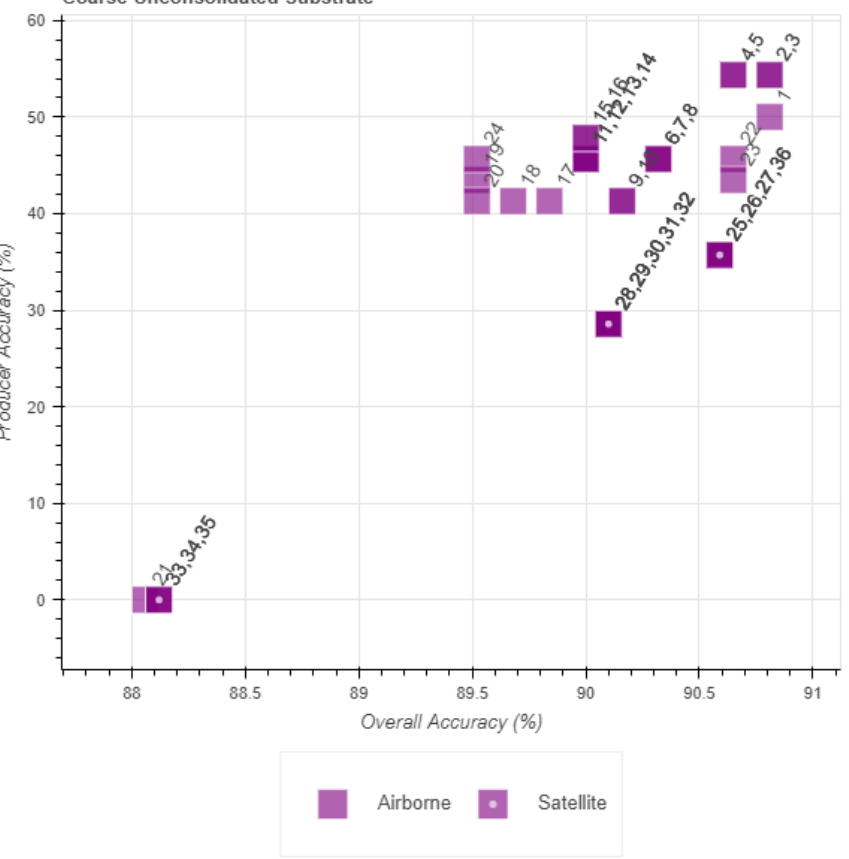
Figure 10. Tier 1 plot of coarse unconsolidated substrate classification performance, comparing percent overall accuracy and percent producer accuracy for airborne and satellite data combinations.